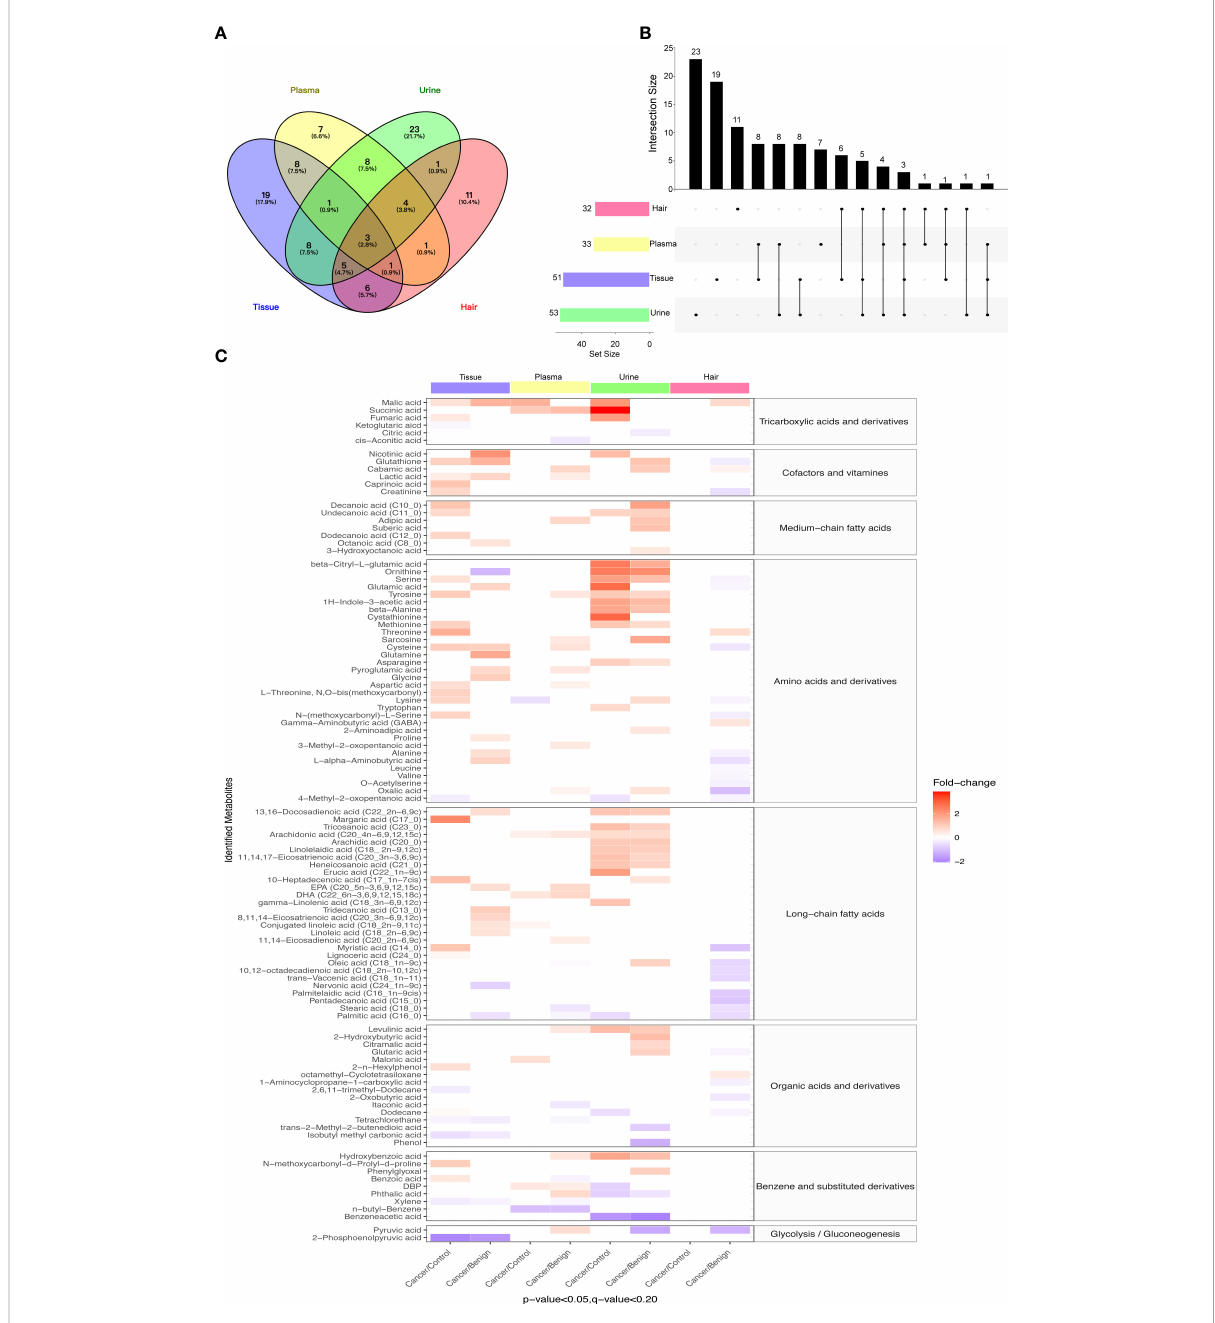
FIGURE 2 Differential metabolites in study subjects of tissue, urine, plasma, and hair samples. (A) Venn diagrams indicated overlapping signi fi cant metabolites (p-value < 0.05, FDR < 0.2) in tissue, plasma, urine, and hair samples. (B) UpSet plot illustrated the number of different signi fi cant metabolites (p-value < 0.05, FDR < 0.2) in tissue, plasma, urine, and hair samples. The individual or connected dots represent the signi fi cant metabolite that was either unique to or shared among comparisons in different samples. (C) The heatmap showed comparative metabolite pro fi les of four specimen types and their associated metabolic classi fi cation. The relative concentrations of sample metabolites are illustrated via log2 scale. Red color blocks represent higher metabolite levels in dividend groups than the divisor groups, whereas blue color blocks represent lower metabolite levels in dividend groups than the divisor groups. Only the metabolites with a p-value (Logistic regression adjusted for gestational age and BMI) less than 0.05 and a q-value (FDR) less than 0.2 are displayed. Number of tissue sample in control group (n = 14), BOT group (n = 16), and OC group (n = 16). Number of plasma sample in control group (n = 13), BOT group (n = 16), and OC group (n = 17). Number of urine sample in control group (n = 13), BOT group (n = 15), and OC group (n = 17). Number of hair sample in control group (n = 13), BOT group (n = 16), and OC group (n =